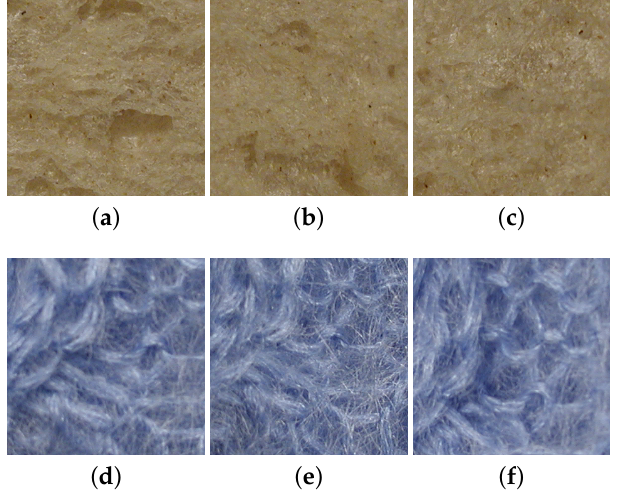
Figure 2. Changes in visual appearance of a white bread sample and a wool sample from the KTH- TIPS2 dataset under various lighting and viewing directions. Images ( a – c ) were captured with a frontal illumination direction and frontal, 22.5° right and 22.5° left viewing directions, respectively, for the white bread sample. Similarly, images ( d – f ) were captured with a frontal illumination direction and frontal, 22.5° right and 22.5° left viewing directions, respectively, for a wool sample.